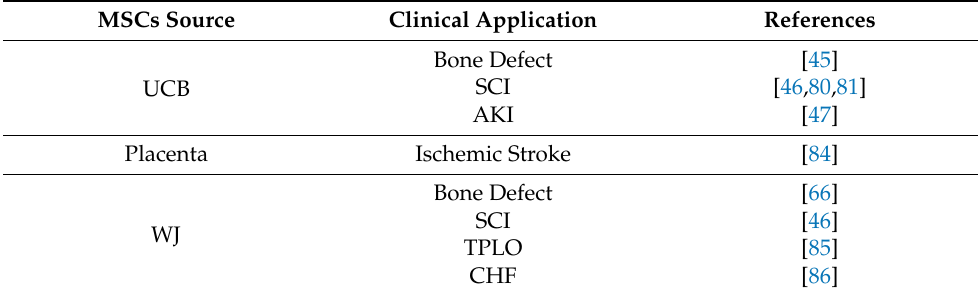
Table 2. Canine foetal fluid and adnexa derived mesenchymal stem cells: clinical